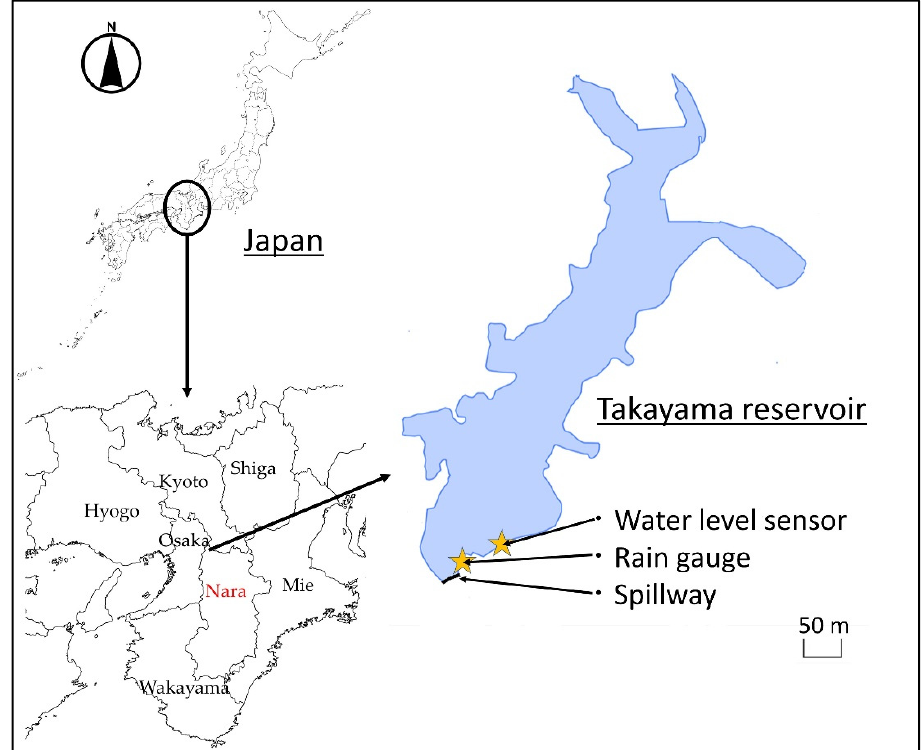
Figure 1. Location of the Takayama Reservoir.